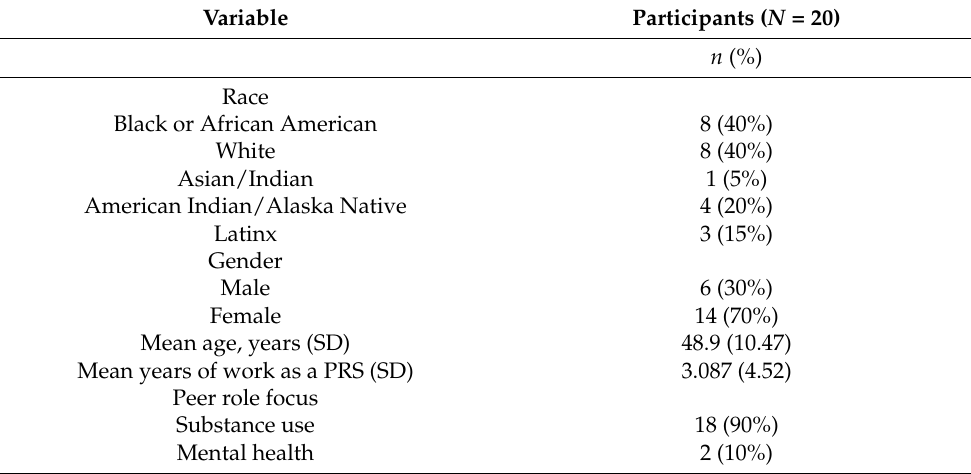
Table 2. Participant demographics.